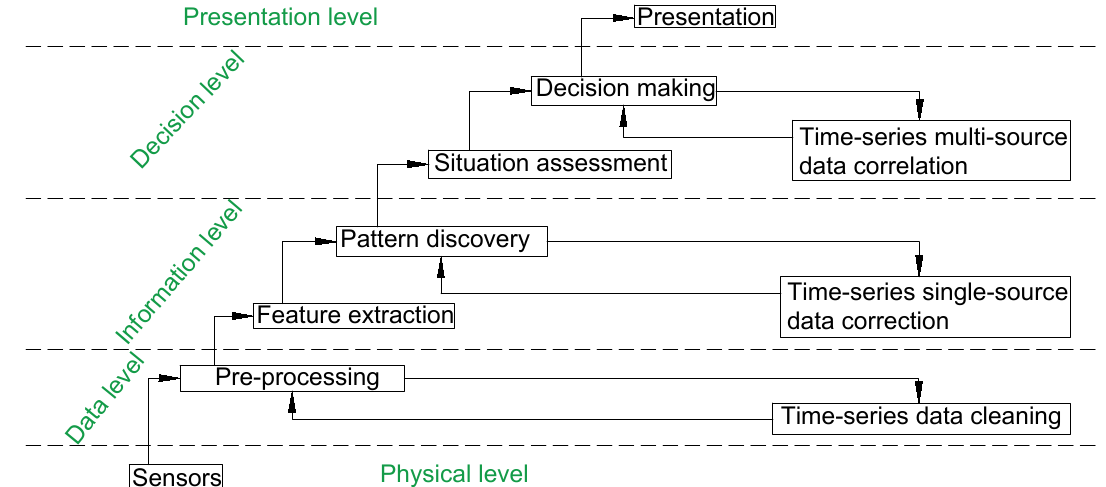
Figure 1. Time-series sensor fusion cascade model with error